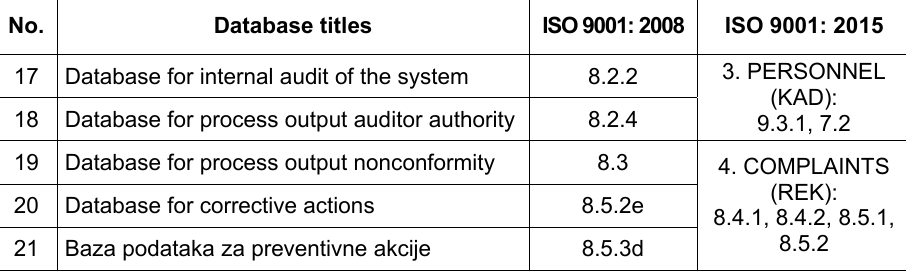
Figure 4 – Overview of the priority databases according to ISO 9001:2015 Рис . 4 – Обзор приоритетных баз данных в соответствии с ISO 9001: 2015 Слика 4 – Преглед приоритетних база података према ISO